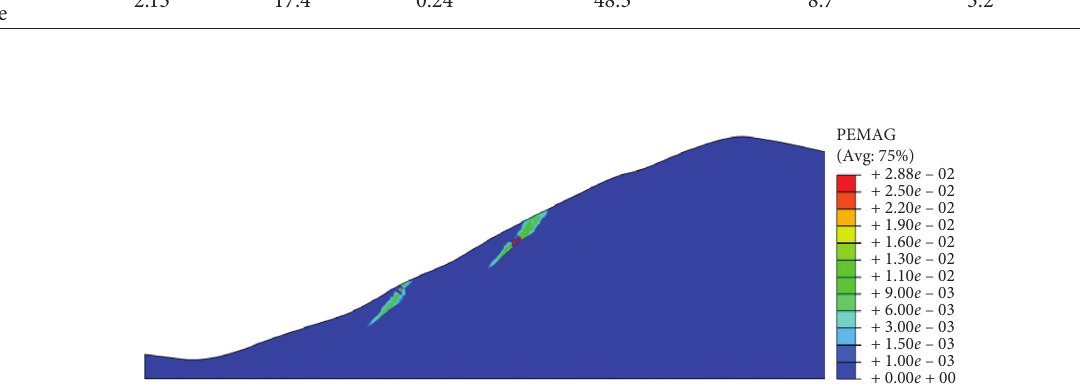
Figure 7: Plastic strain cloud map of the slope at t � 0.312s.